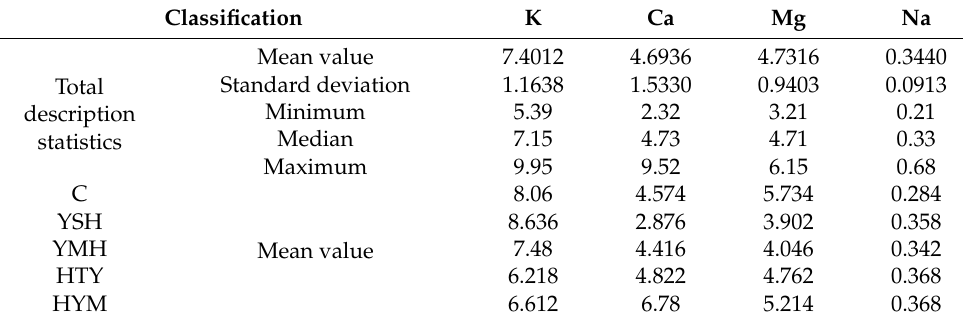
Table 2. Descriptive analysis of soil nutrients.